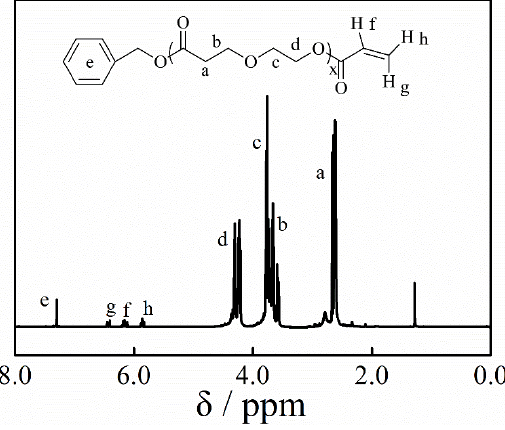
Figure 2. 1 H NMR spectrum of PDXO catalyzed with t -BuP 4 in bulk at 60 ◦ C (2 h) (Table 1, H6).